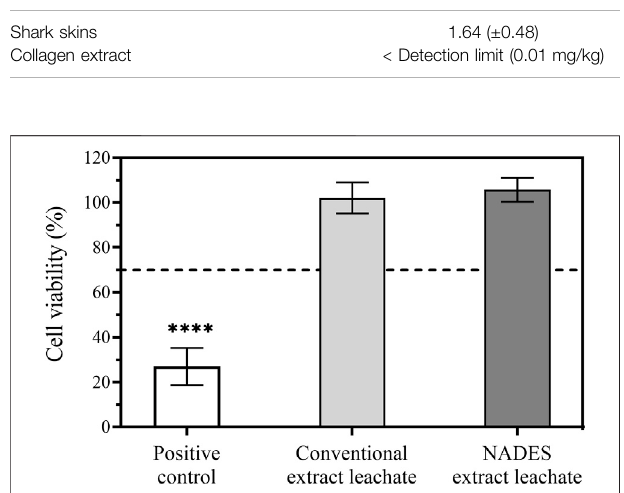
FIGURE 6 | Cytotoxicity assay using MTS reagent: leached extracts were incubated in NCTC clone 929 cell line for 24 h at 37 ° C and 5% CO2 humidi fi ed atmosphere (mean ± SD, n = 3). Statistically signi fi cant differences comparing all conditions are indicated by **** ( p <